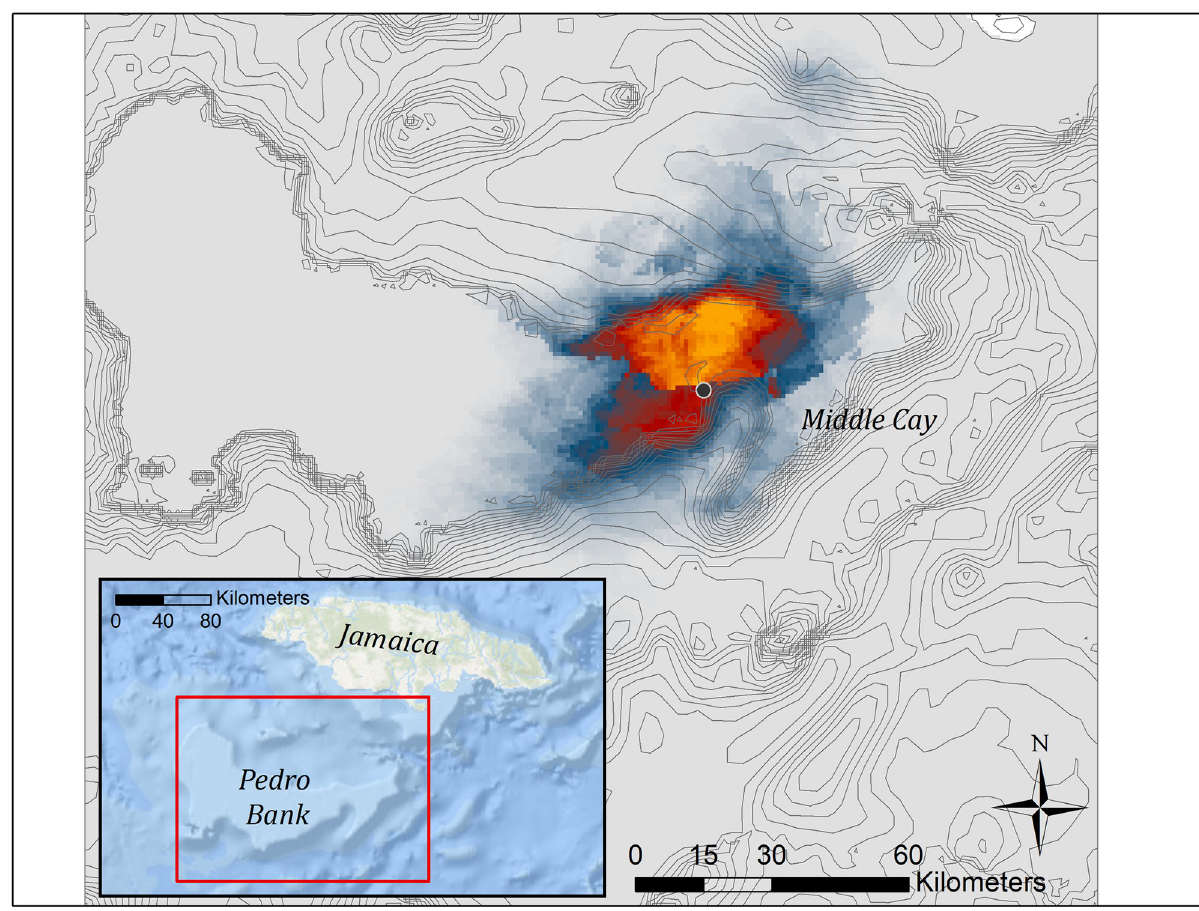
Fig 3. Output of Maxent habitat modeling for Masked Boobies from Middle Cay based on a suite of oceanographic figures. Areas of high suitability are represented by increasingly yellow colors. Lower use areas are represented by increasingly blue colors.